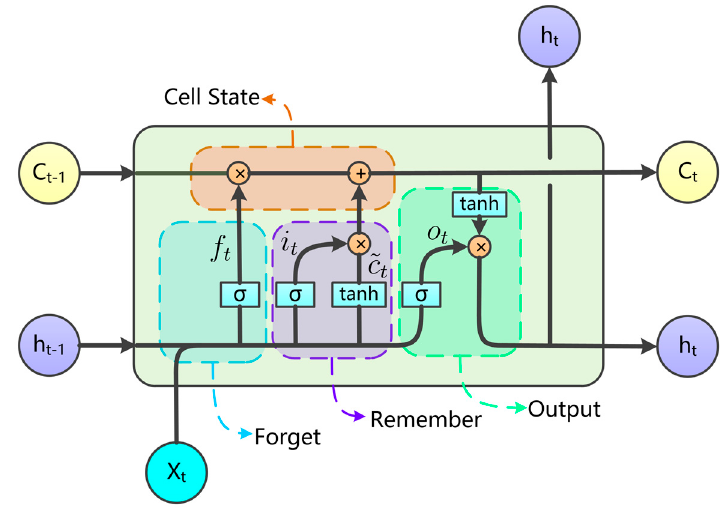
Figure 3. Schematic diagram of logical architecture of LSTM network unit.